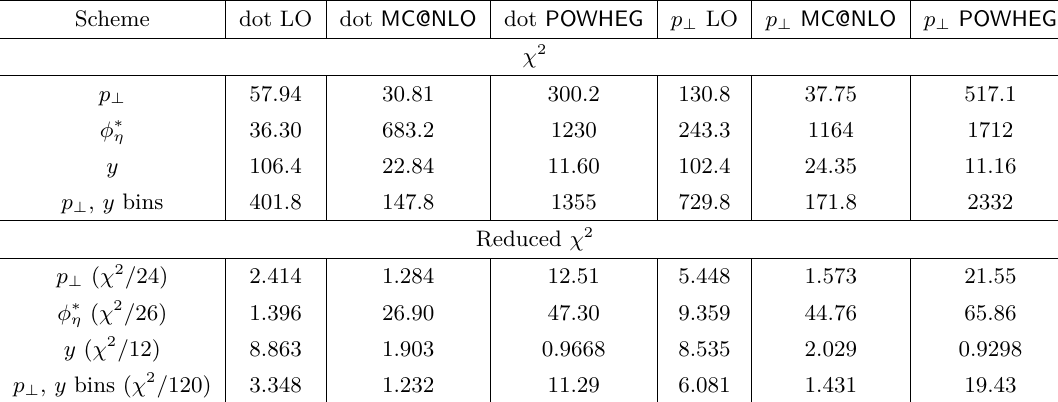
Table 2 . χ 2 results for Z Drell-Yan distributions at 13 TeV compared to CMS data [20]. For the Z -boson transverse momentum distributions, the χ 2 is computed only in the region p ⊥ < 50 GeV, while for φ ∗ we consider only φ ∗ < 0 . 8 . The “ p ⊥ , y bins” rows refer to the p ⊥ distributions broken η η up into 5 distributions based on y